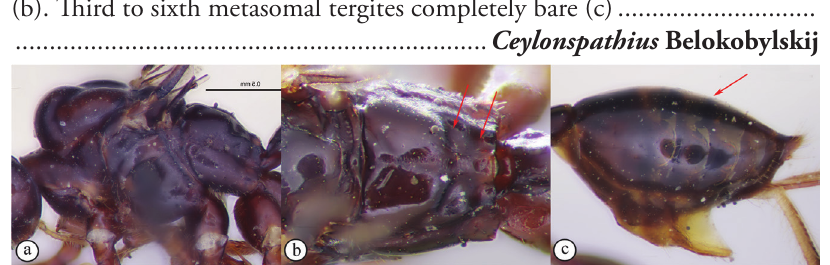
– Prepectal (epicnemial) carina absent (a). Propodeum with several depressions (b). Third to sixth metasomal tergites completely bare (c) .............................